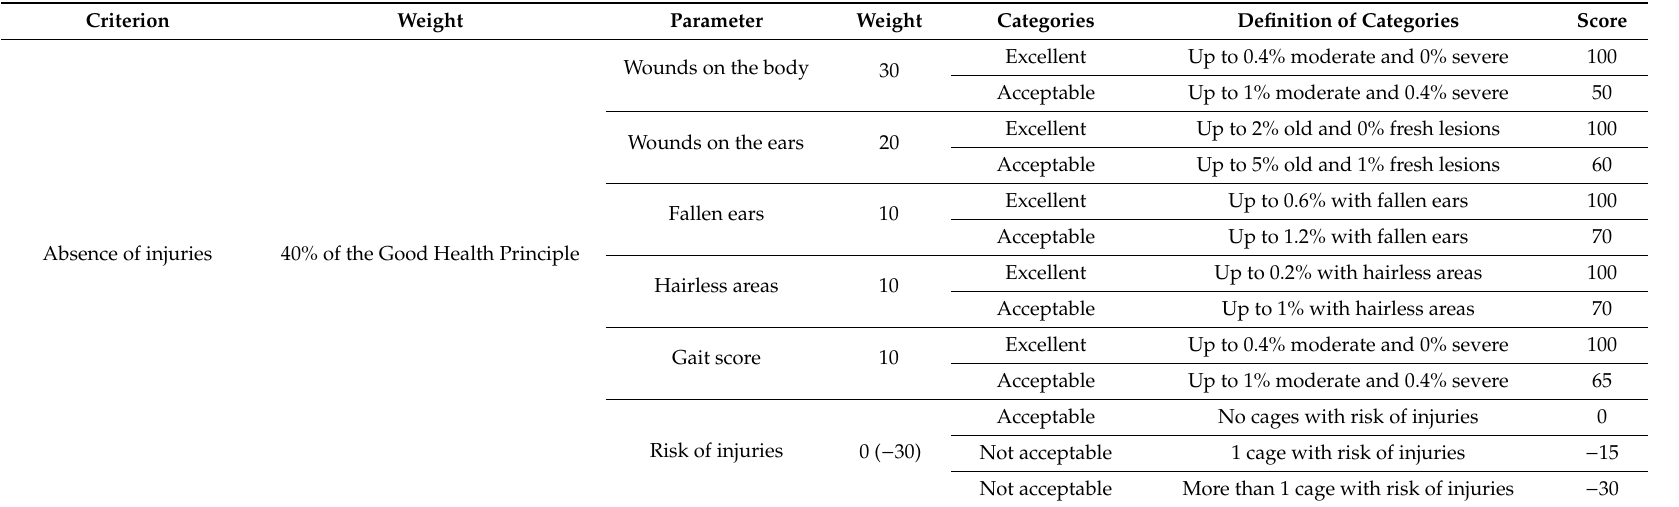
Table 4. Parameters used to assess the absence of injuries, absence of diseases and pain induced by management procedures criteria within the Good Health Principle. The weight means which percentage of the score of the total criterion is represented by each parameter. Some parameters, such as risk of injuries, are only considered in the score when the acceptable value is not achieved, subtracting points from the overall score. Each parameter can be assessed according to two categories and are scored accordingly. In some cases, the category Not acceptable can have more than one